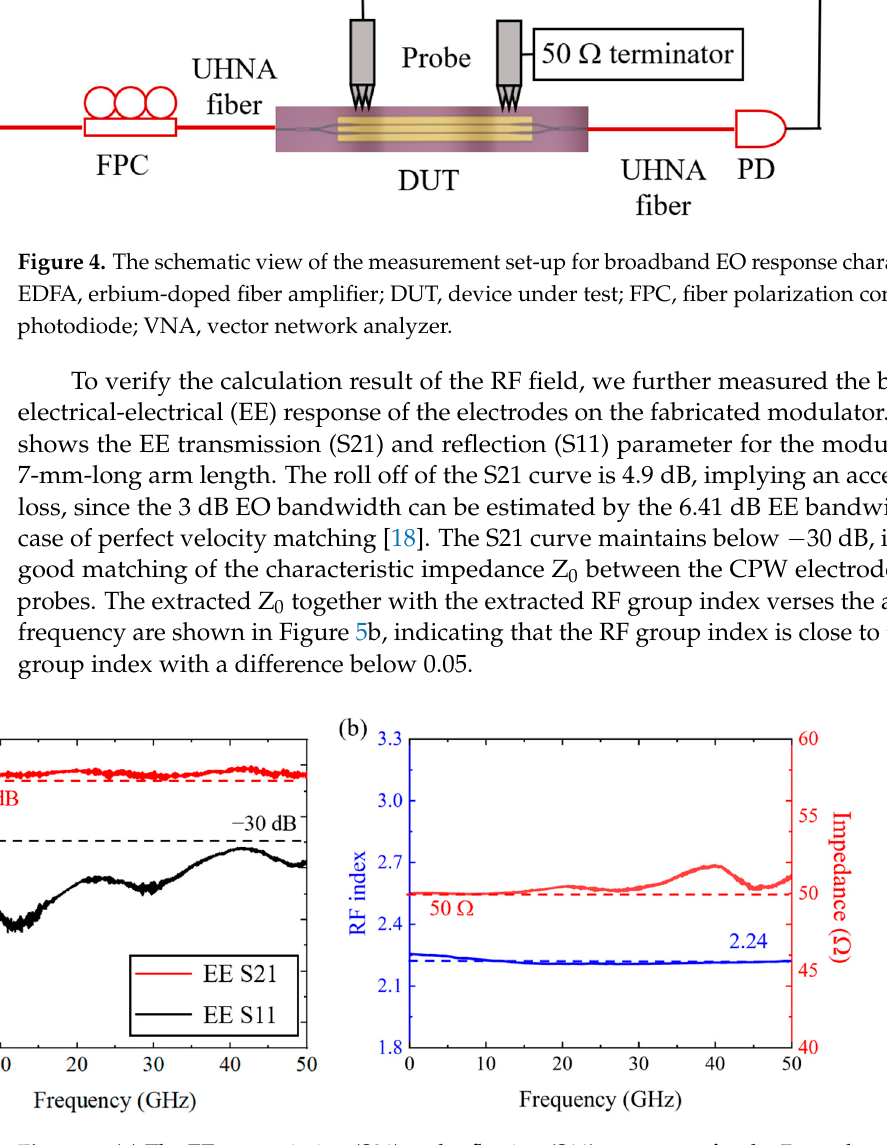
Figure 5. ( a ) The EE transmission (S21) and reflection (S11) parameter for the 7-mm-long modulator. ( b ) The extracted RF group index curve and characteristic impedance curve of the coplanar waveguide (CPW) electrodes.